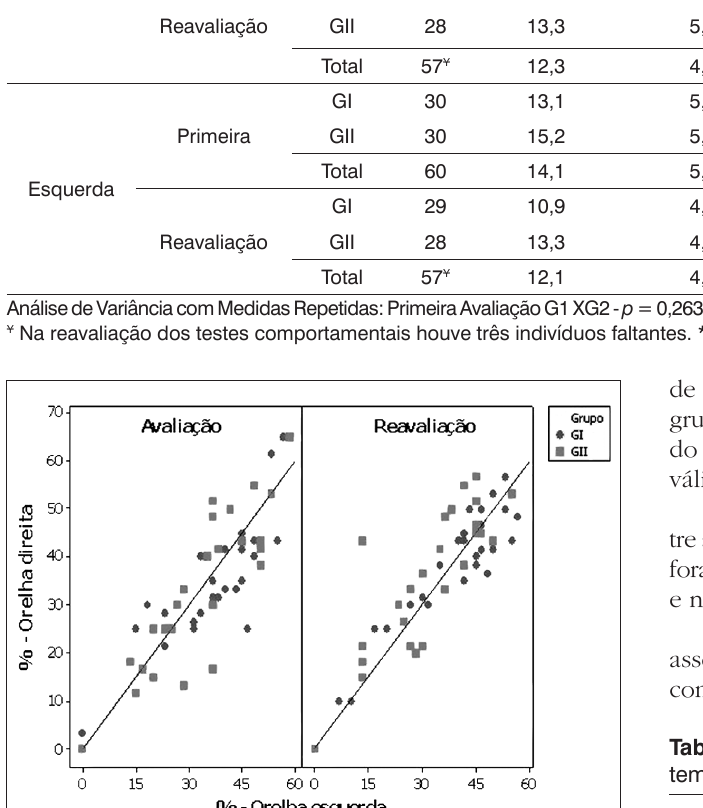
Tabela 4. Coeficientes de correlação de Spearman dos testes temporais com a Idade e